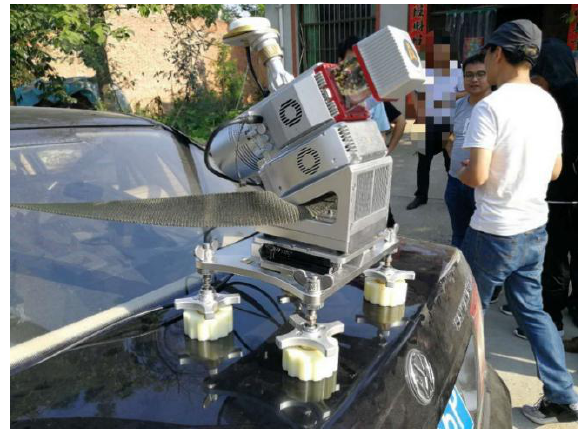
Figure 5 Vehicle point cloud data acquisition